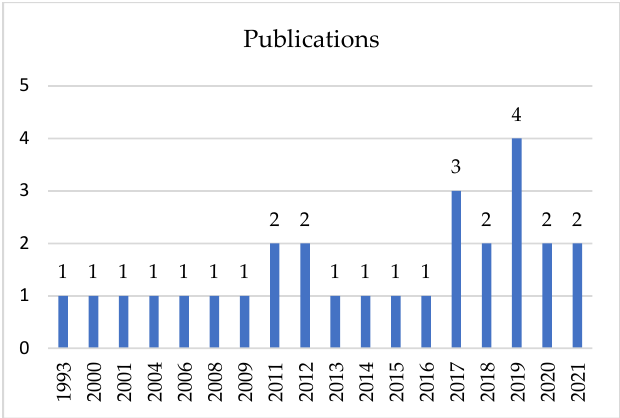
Figure 2. Annual publications corresponding to selected articles.